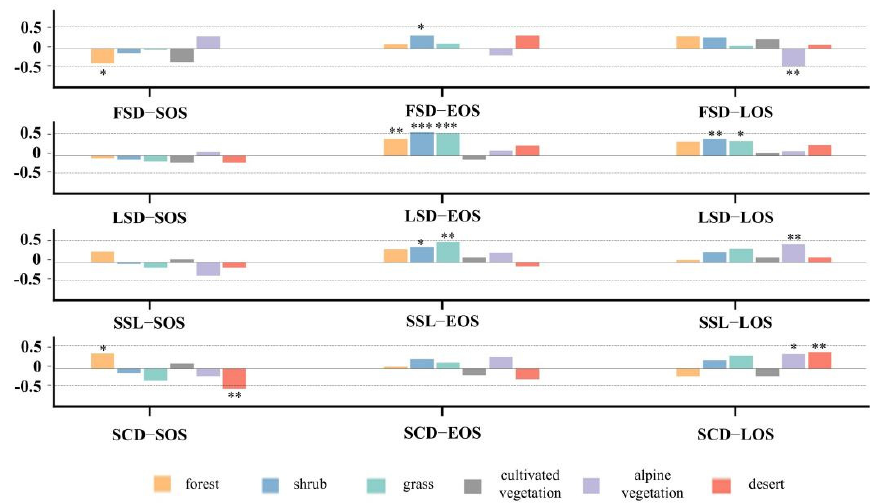
Figure 10. Correlation between vegetation phenological metrics of eight types of vegetation and snow phenological metrics. * p < 0.1, ** p < 0.05, *** p < 0.01.